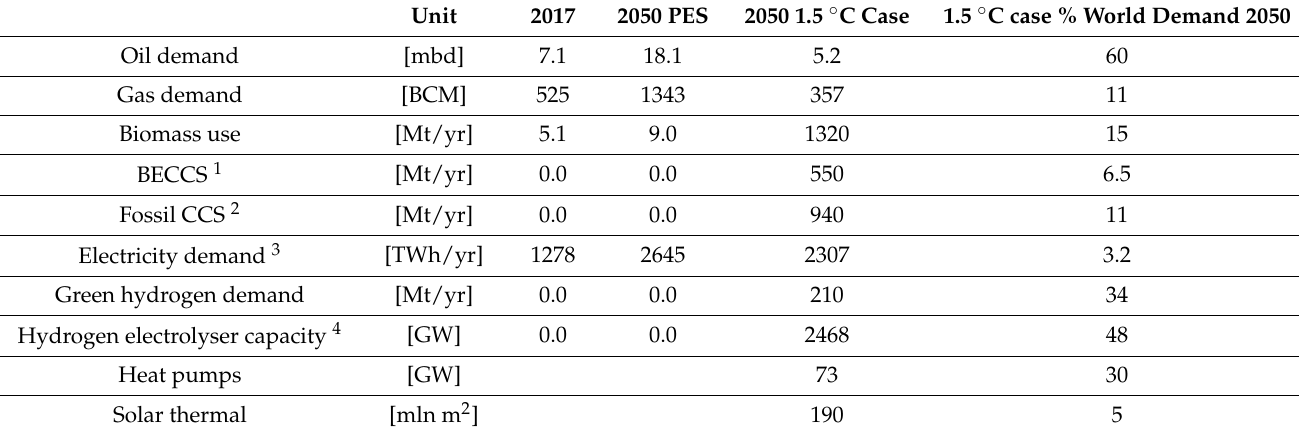
Table 6. Indicators for energy systems relevance of the chemical and petrochemical